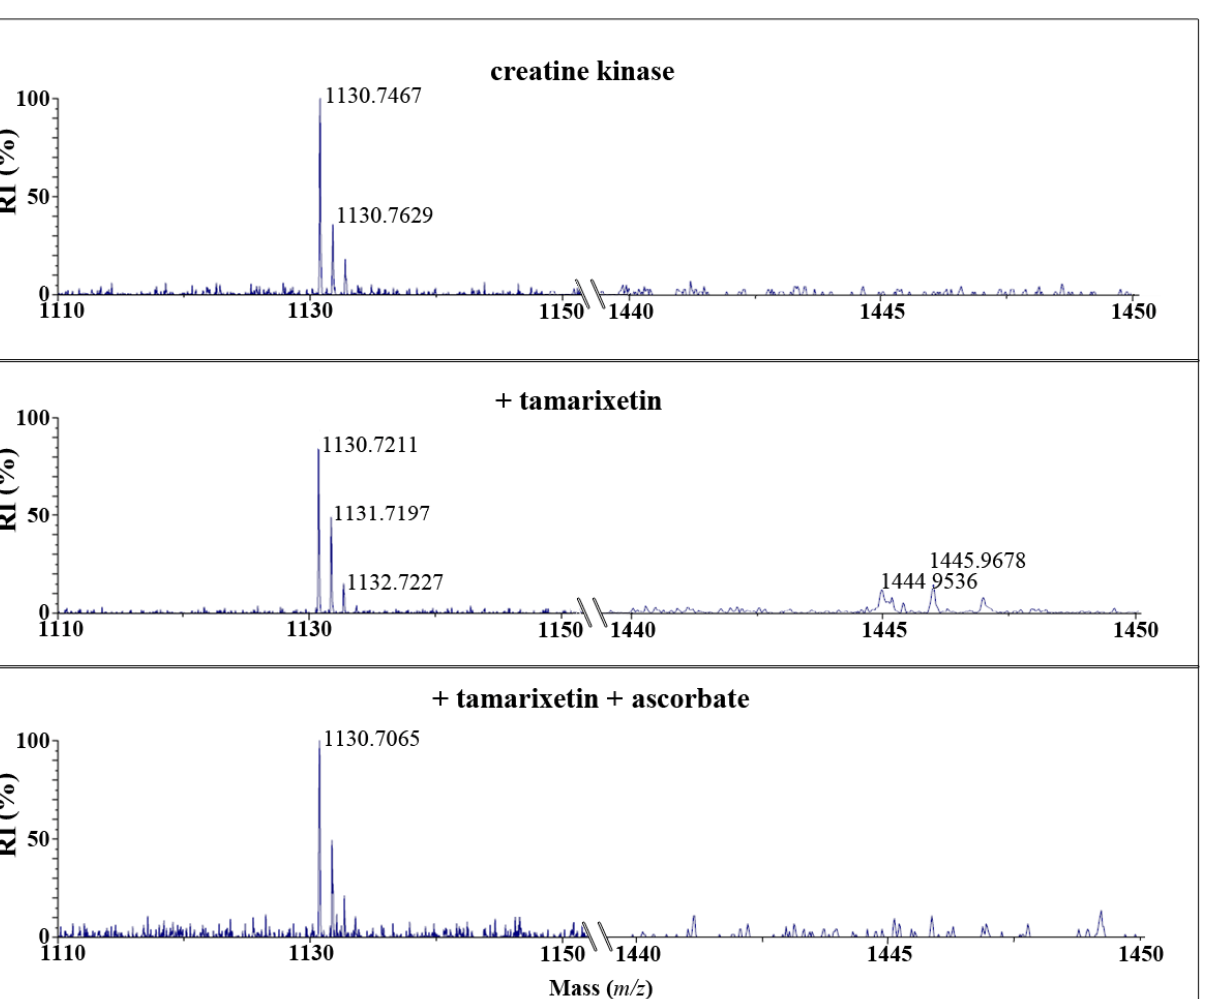
Figure 4. MALDI-ToF analysis of isolated creatine kinase (CK) (0.5 mg/mL) incubated with 50 µM tamarixetin, 3.2 nM HRP and 50 µM H O with or without 50 µM ascorbate 2 2 for 5 min at 37 °C. After trypsin digestion the mass spectrum of digested CK was measured. The control spectrum of CK displayed a peak at m / z 1130 and no peak at m / z 1444. The incubation with tamarixetin showed a peak at m / z 1444 which corresponds to the mass of the adduct of tamarixetin quinone (314 dalton) with the peptide having mass m / z 1130, whereas the peak at m / z 1130 decreased. The amino acid sequence of the peptide is GYTLPPHCSR, containing cysteine 146. The spectrum of CK incubated with tamarixetin in combination with ascorbate did not show a decrease in the intensity of the peak at m / z 1130 and an increase at m / z